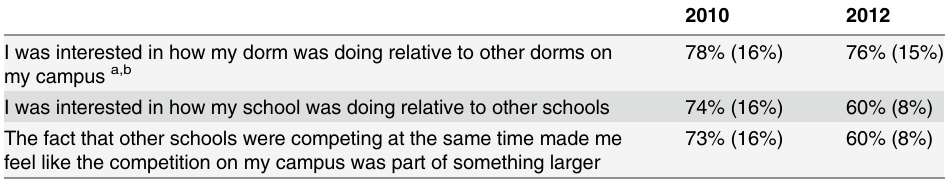
Table 4. Influence of social comparison on participation in the